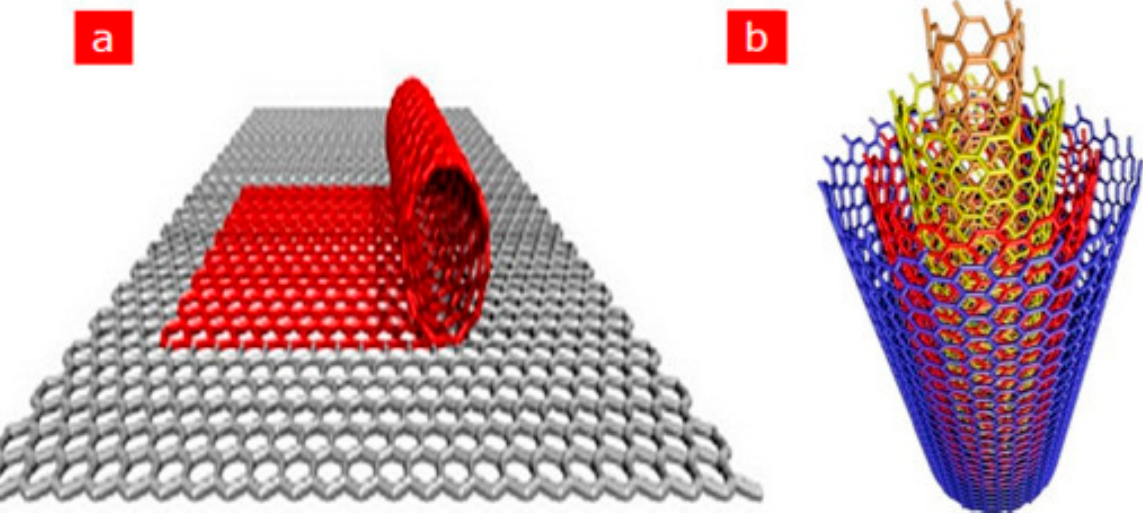
Figure 1. Schematic representation of ( a ) SWCNTs comprising a single graphite layer ( b ) MWCNTs comprising multiple graphite layers. Adapted from Ref. [47] with authorisation from Elsevier.